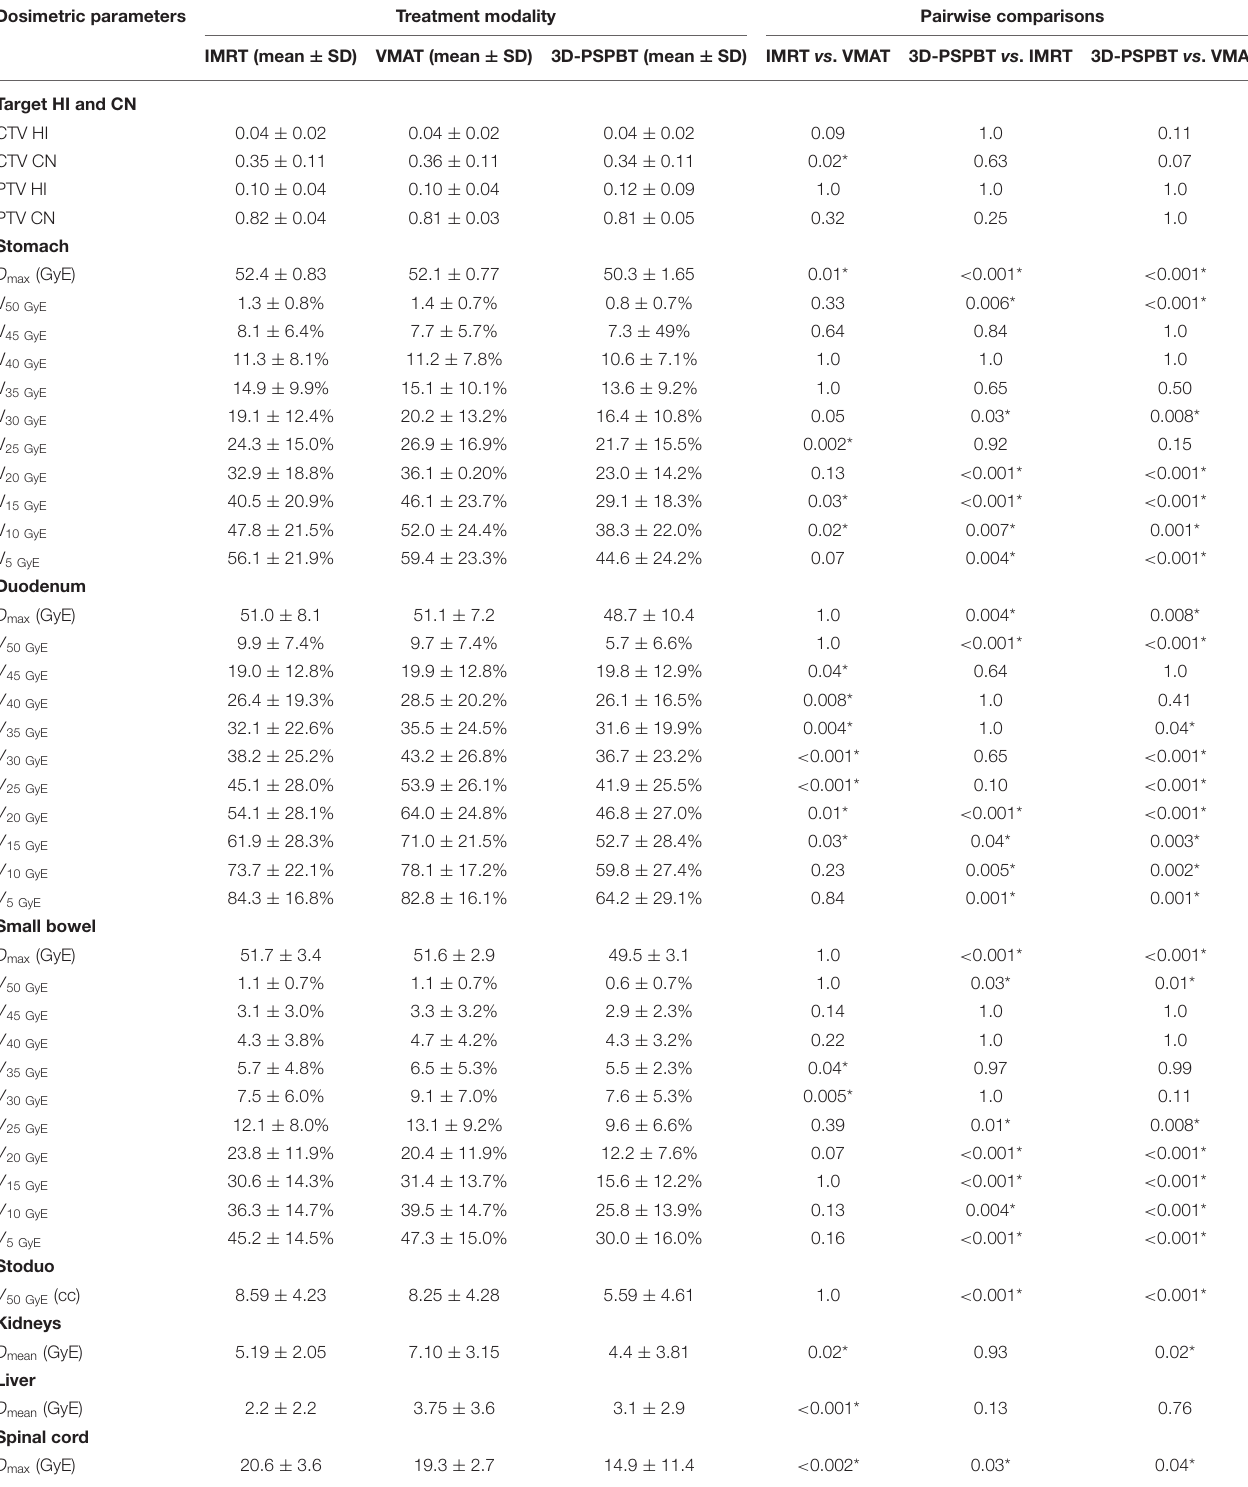
TABLE 3 | Comparison of the target homogeneity and conformity data and the organ at risk (OAR) dosimetric data obtained with the intensity-modulated radiotherapy (IMRT), volume-modulated arc therapy (VMAT), and 3D-passive scattering proton beam therapy (3D-PSPBT) plans. Dosimetric parameters Treatment modality Pairwise